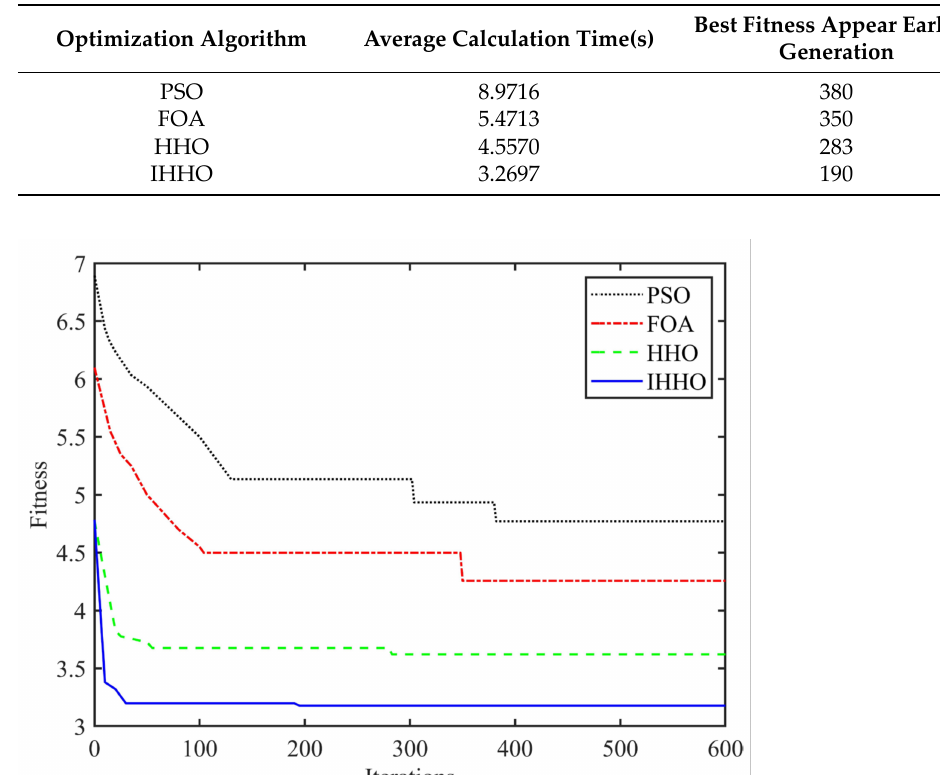
Table 7. Computational efficiency results of four optimization algorithms.